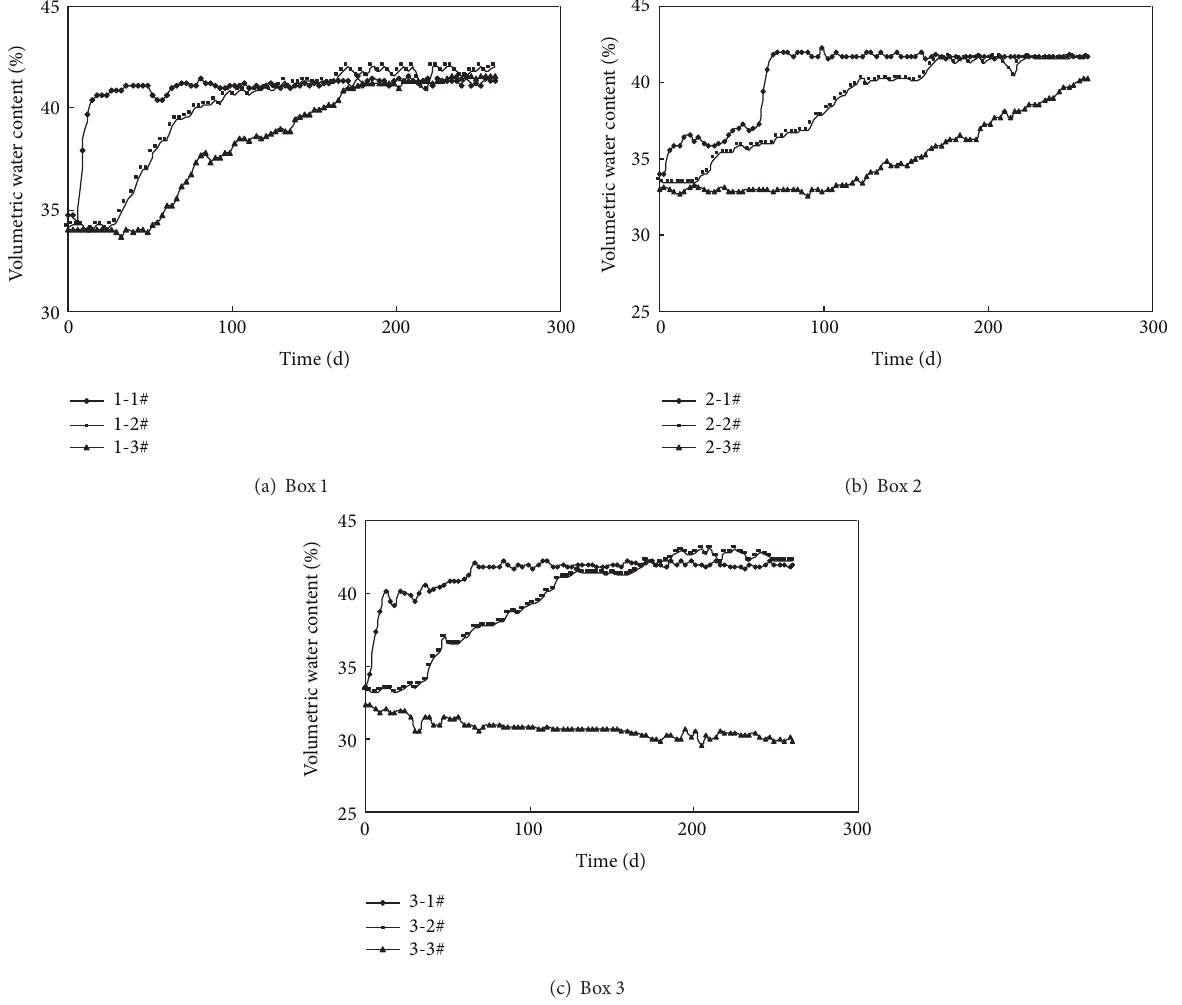
Figure 11: Variations of subgrade moisture in model boxes 1, 2, and